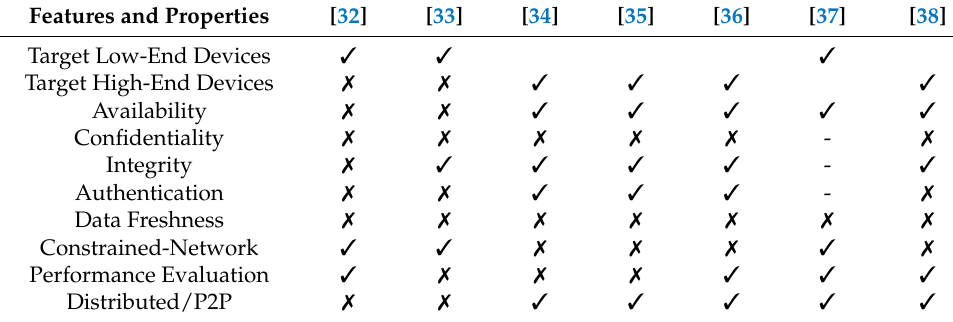
Table 3. The Comparison Between the Firmware Update Mechanisms.